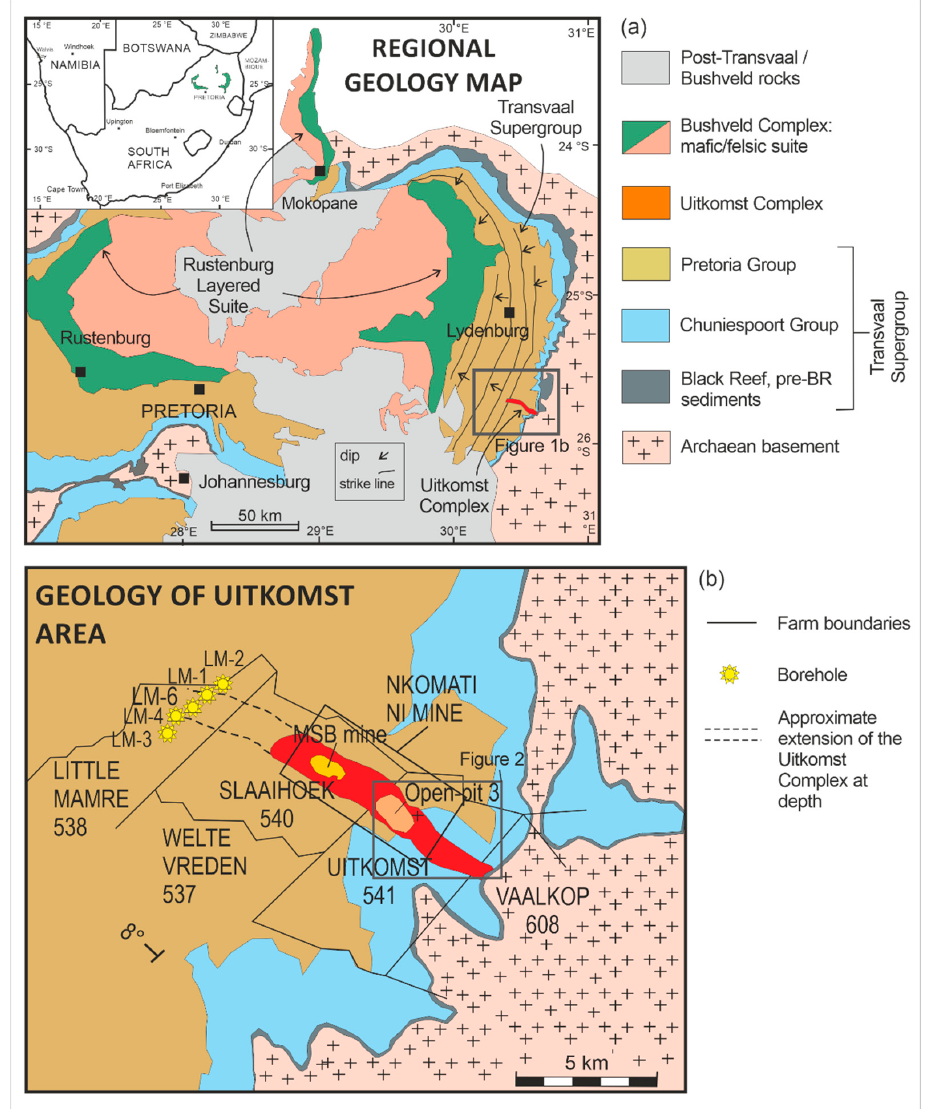
Figure 1. Regional geological map of ( a ) the Bushveld Complex, the Transvaal Supergroup basin and ( b ) the Uitkomst Complex with situation of the Nkomati Ni Mine, including 2 shafts at the Massive Sulphide Body (MBS) underground mine and the Open-pit 3 operation. Abbreviations, dip: dip direction, LM: Little Mamre.